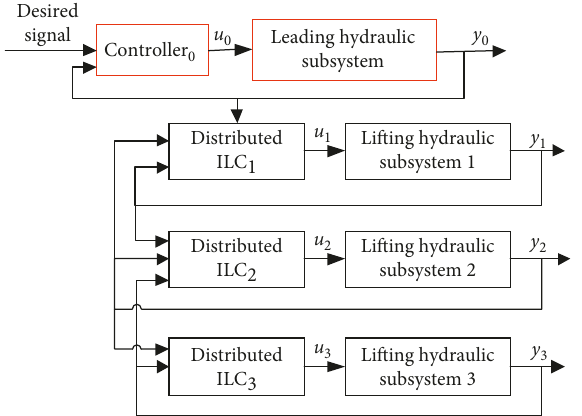
Figure 2: Illustration of the proposed distributed control